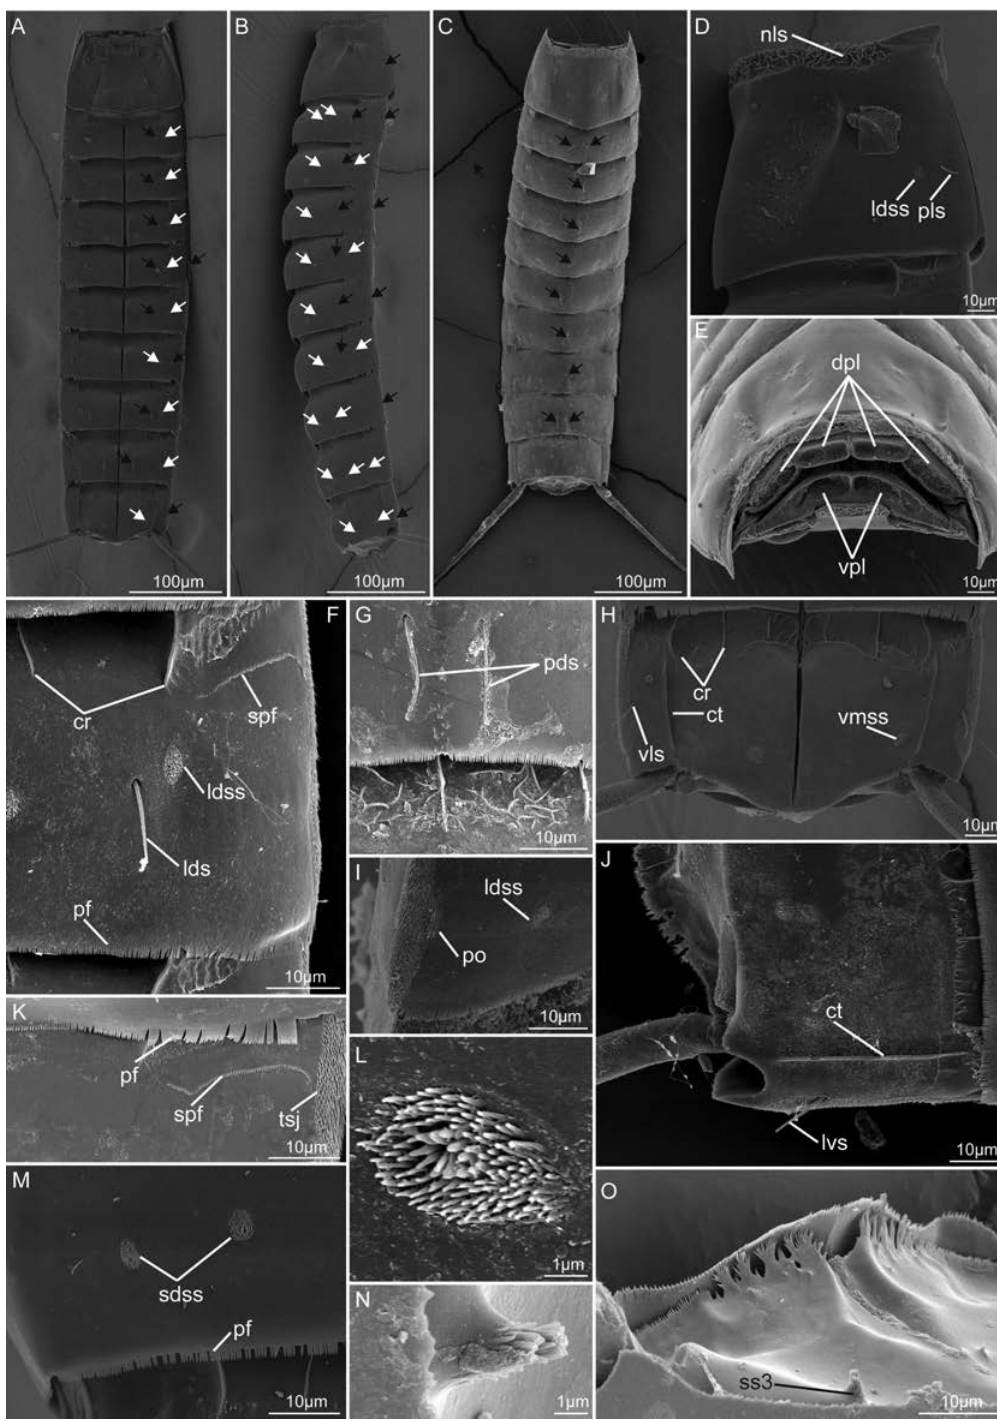
F ig . 3. – Pycnophyes pardosi n. sp. SEM photographs. A, female, ventral view; B, female, lateral view; C male, dorsal view; D, female, lateral view of segment 1; E, male, anterior view of segment 1, dorsal and ventral placids; F, female, dorsal view of right half of segment 3; G, male, dorsal view of paradorsal regions of segment 9; H, female, ventral view of segment 10; I, female, dorsolateral view of segment 9; J, female, dorsal view of right half of segment 10; K, male, detail in anterior laterodorsal position on segment 3; L, female, subdorsal sensory spot of segment 4; M, female, dorsal view of left half of segment 8; N, male, sensory spot type 3 of segment 11; O, male, dorsal view of segment 11, showing the special shape of the posterior fringe; cr cuticular ridge, ct cuticular thickening, dpl dorsal placid, lds laterodorsal seta, ldss latero- dorsal sensory spot, lvs lateroventral seta, nls net-like structure, pds paradorsal seta, pf pectinate fringe, pls paralateral seta, po protonephridial opening, sdss subdorsal sensory spot, spf secondary pectinate fringe, ss3 sensory spot type 3, tsj tergosternal junction, vls ventrolateral seta, vmss ventromedial sensory spot, vpl ventral placid. Sensory spots are marked with white arrows and setae with black arrows